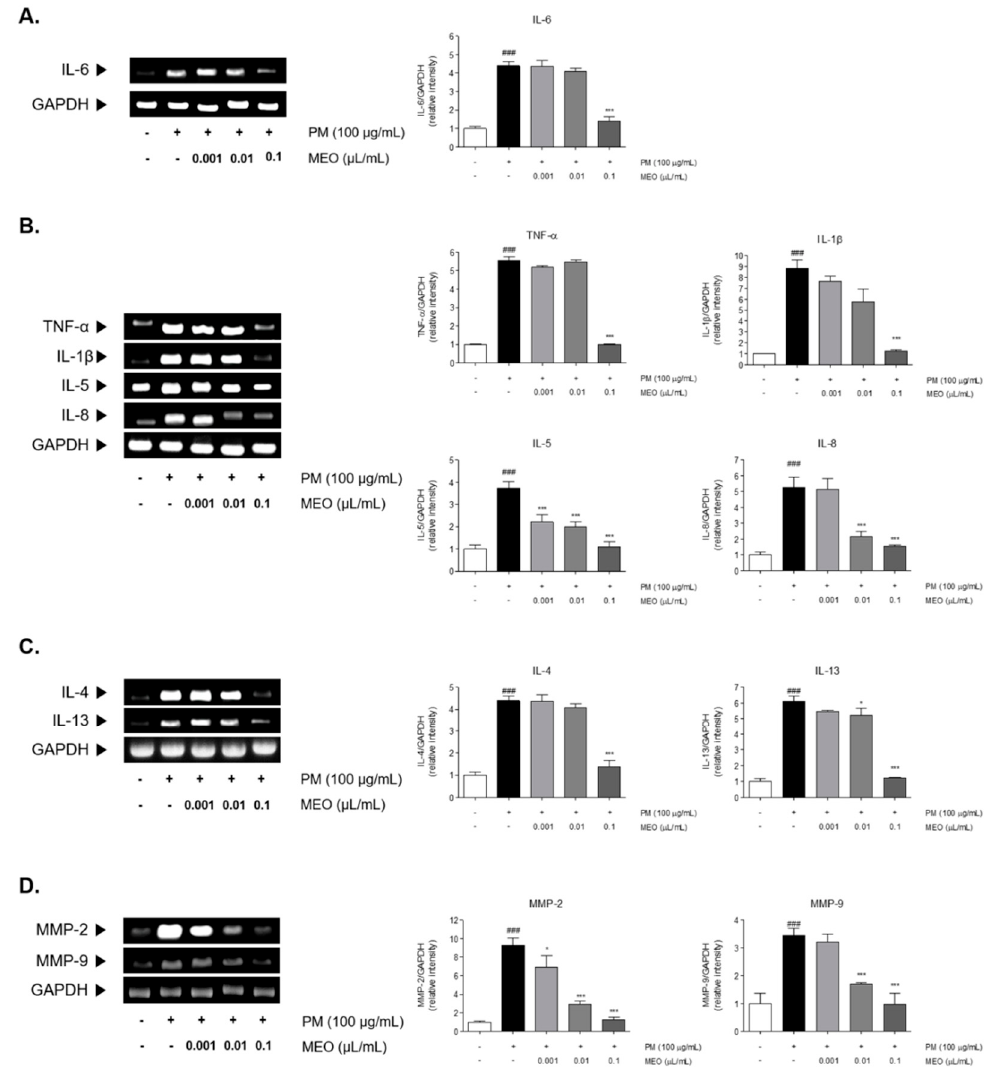
Figure 4. The mRNA expressions of IL-6 ( A ), inflammatory cytokines including TNF- α , IL-1 β , IL-5 and IL-8 ( B ), Th2-specific cytokines including IL-4 and IL-13 ( C ), and MMP-2 and MMP-9 ( D ) in PM 10 -exposed A549 lung epithelial cells. The experiments were carried out in triplicate measurements. Results are presented as mean ± standard error of the mean. ### p < 0.001 vs. non-treated cells; * p < 0.05, and *** p < 0.001 vs. PM 10 -treated cells.